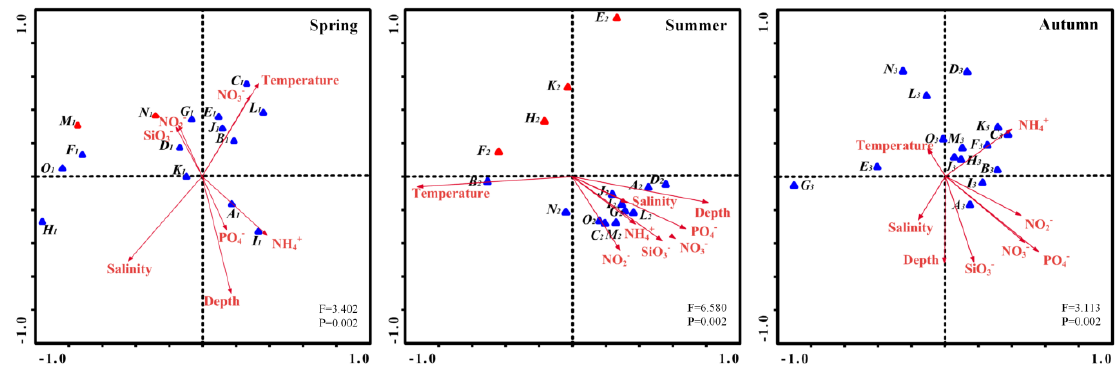
Figure 9. Ordination diagram of canonical correspondence analysis (CCA) exhibits phytoplankton community and environmental variables (arrows) during summer, spring, and autumn in the BS and NYS. A-O indicates the top 15 dominant species in each season listed in Table 2, the red triangles are Pyrrophyta and the blue triangles are Bacillariophyta.